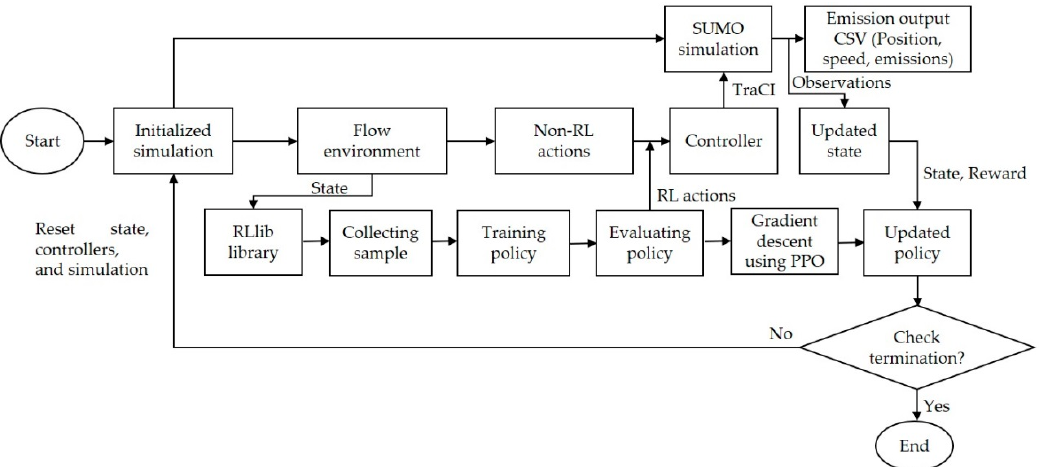
Figure 2. The proposed method’s architecture.